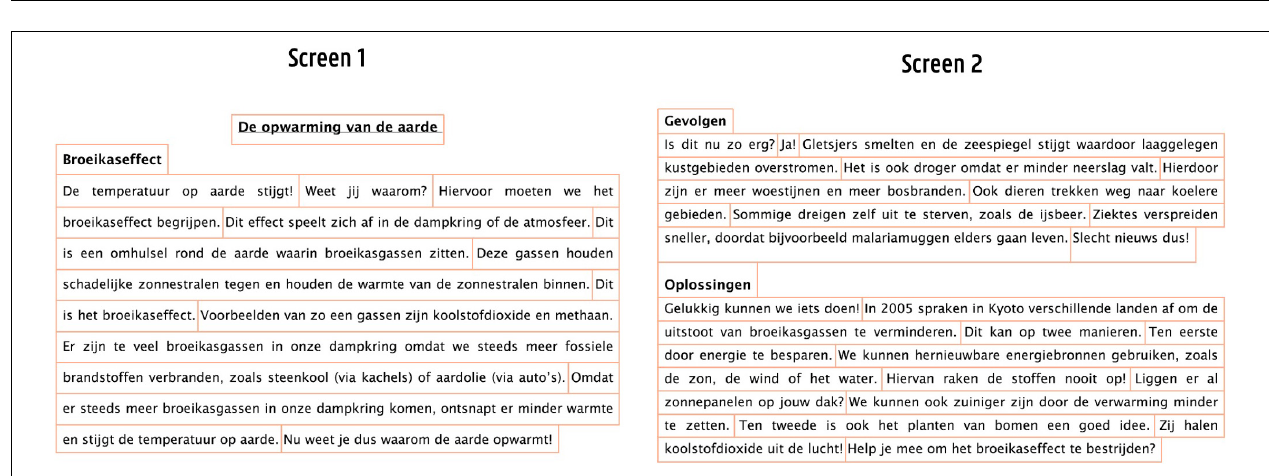
FIGURE 6 | Informative text on global warming presented on two subsequent screens. The boxes represent the Interest Areas (AoI) and were not visible for the participants (see further). Since the focus of this study lies on the visual behavior pattern in the mind map, detailed analysis on the informative texts are not under investigation in this